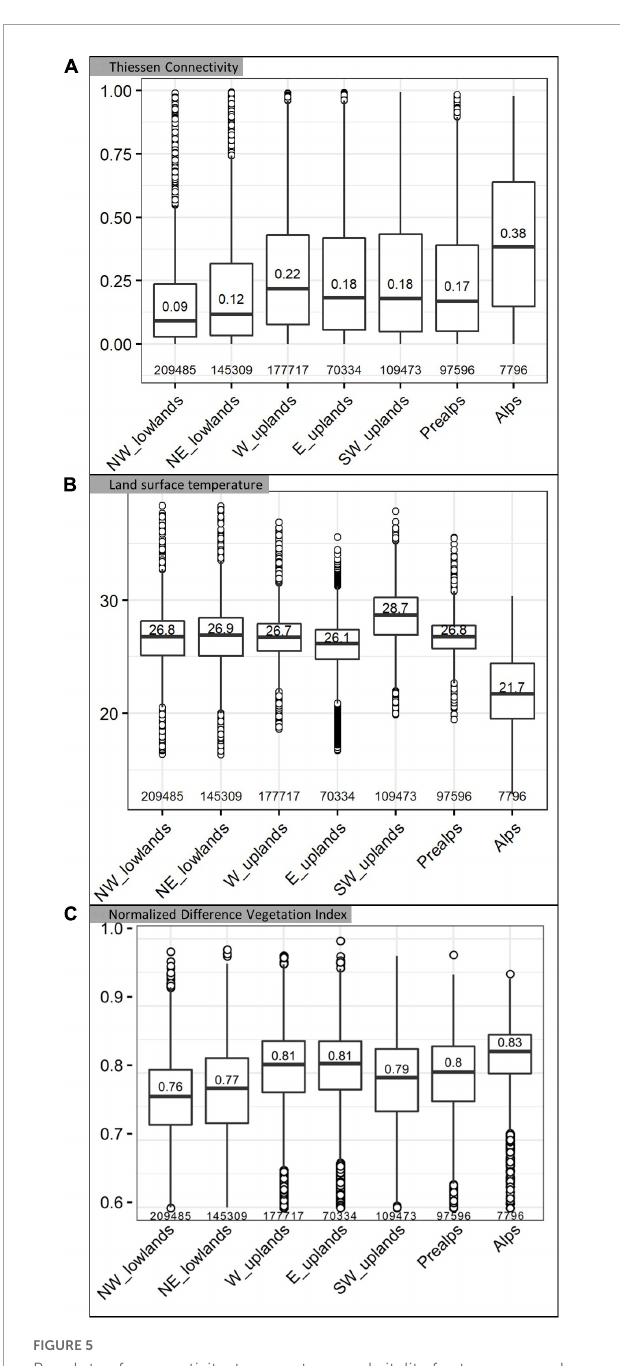
FIGURE5 Boxplots of connectivity, temperature, and vitality for tree-covered areas in Germany 2022 per ecoregion including all values regardless of the size of a fragment. The median of each dataset per boxplot is depicted as a bold horizontal line, the line above represents the upper quartile of which 75% of the values fall below and the line below the median represents the lower quartile with 25% of the values below. (A) Thiessen connectivity for forest-covered areas in Germany as of 2022. (B) Land surface temperature (LST) based on the mean of the hottest days in 2022. (C) Vitality (NDVI) based on the maximum value of the growing season in 2022 (for better readability, outliers below 0.6 are not depicted). The count of data points per ecoregion is depicted above the X